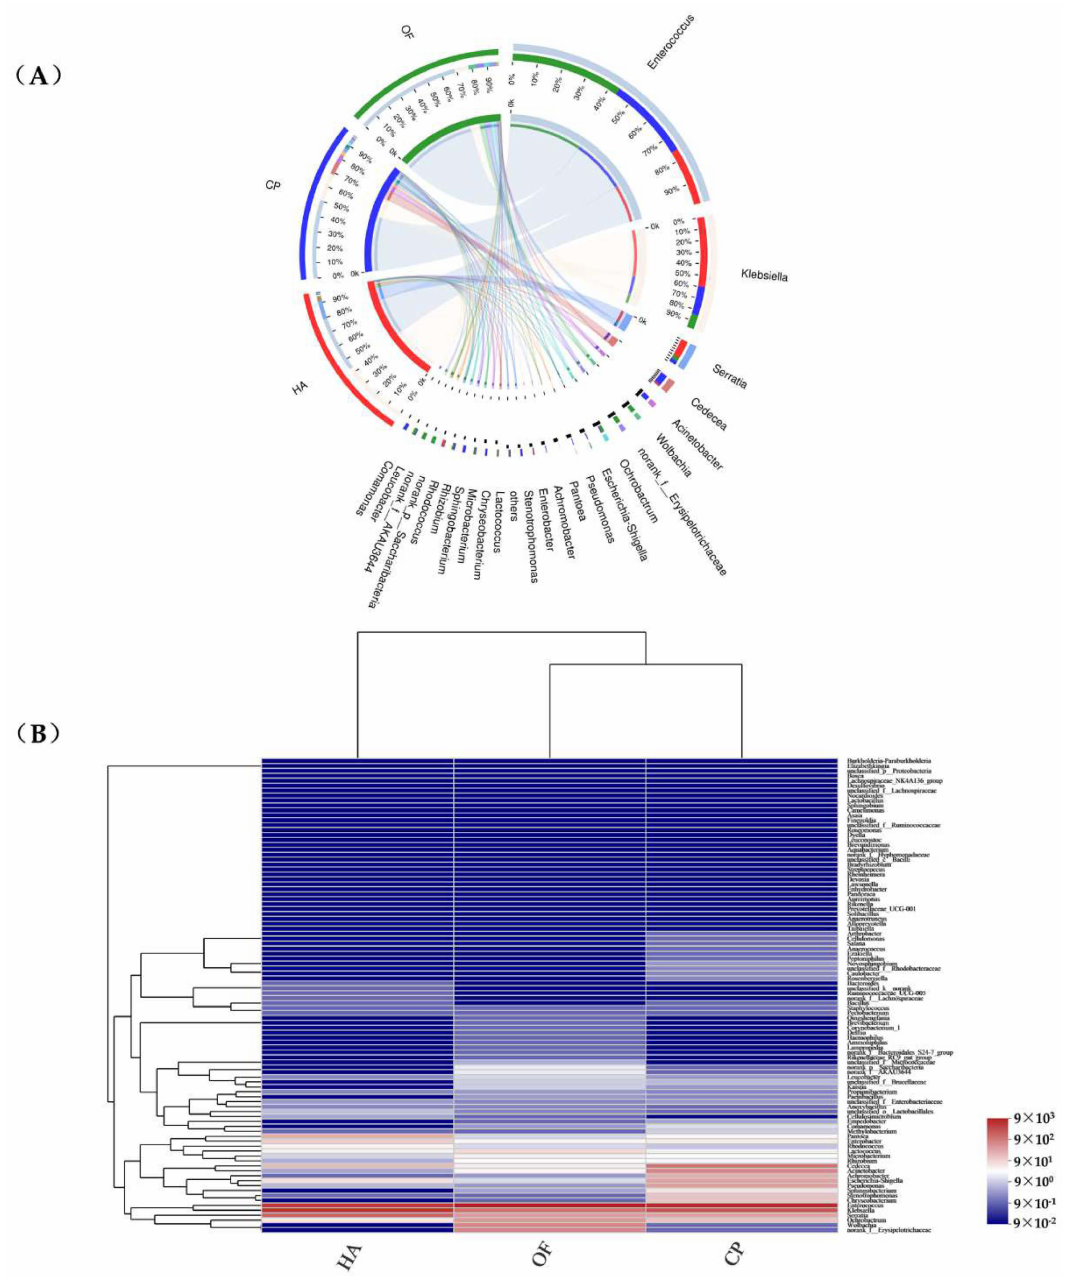
Figure 2. Circos ( A ) and distance heatmap ( B ) based on genus level. Circos ( A ) shows distribution proportion of dominant species in each sample and distribution proportion of dominant species in different samples. The columns ( B ) represent the samples and the rows represent the bacterial assigned to the genus level. Dendrograms of hierarchical cluster analysis grouping genera and samples are shown on the left and bottom, respectively. The color scale represents the normalized values of relative abundances by log10. HA, H. armigera ; CP, C. punctiferalis ; OF, O. furnacalis . Taxa with an abundance <1% are included in